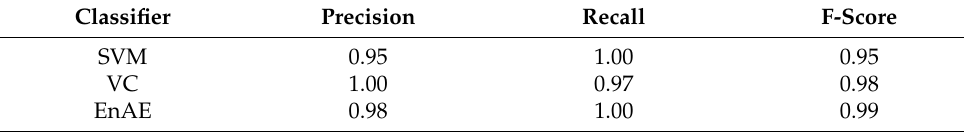
Table 8. Results of assessing the quality of the classification of adversarial examples. Classifier